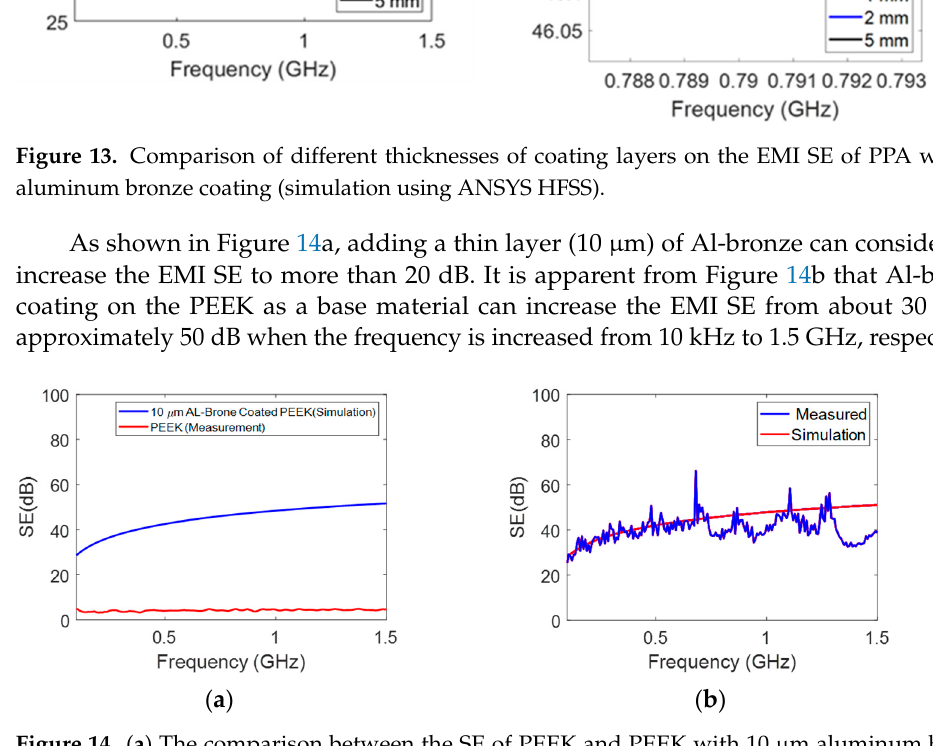
Figure 14. ( a ) The comparison between the SE of PEEK and PEEK with 10 µm aluminum bronze coating; ( b ) EMI SE of PEEK-based material with aluminum coating.